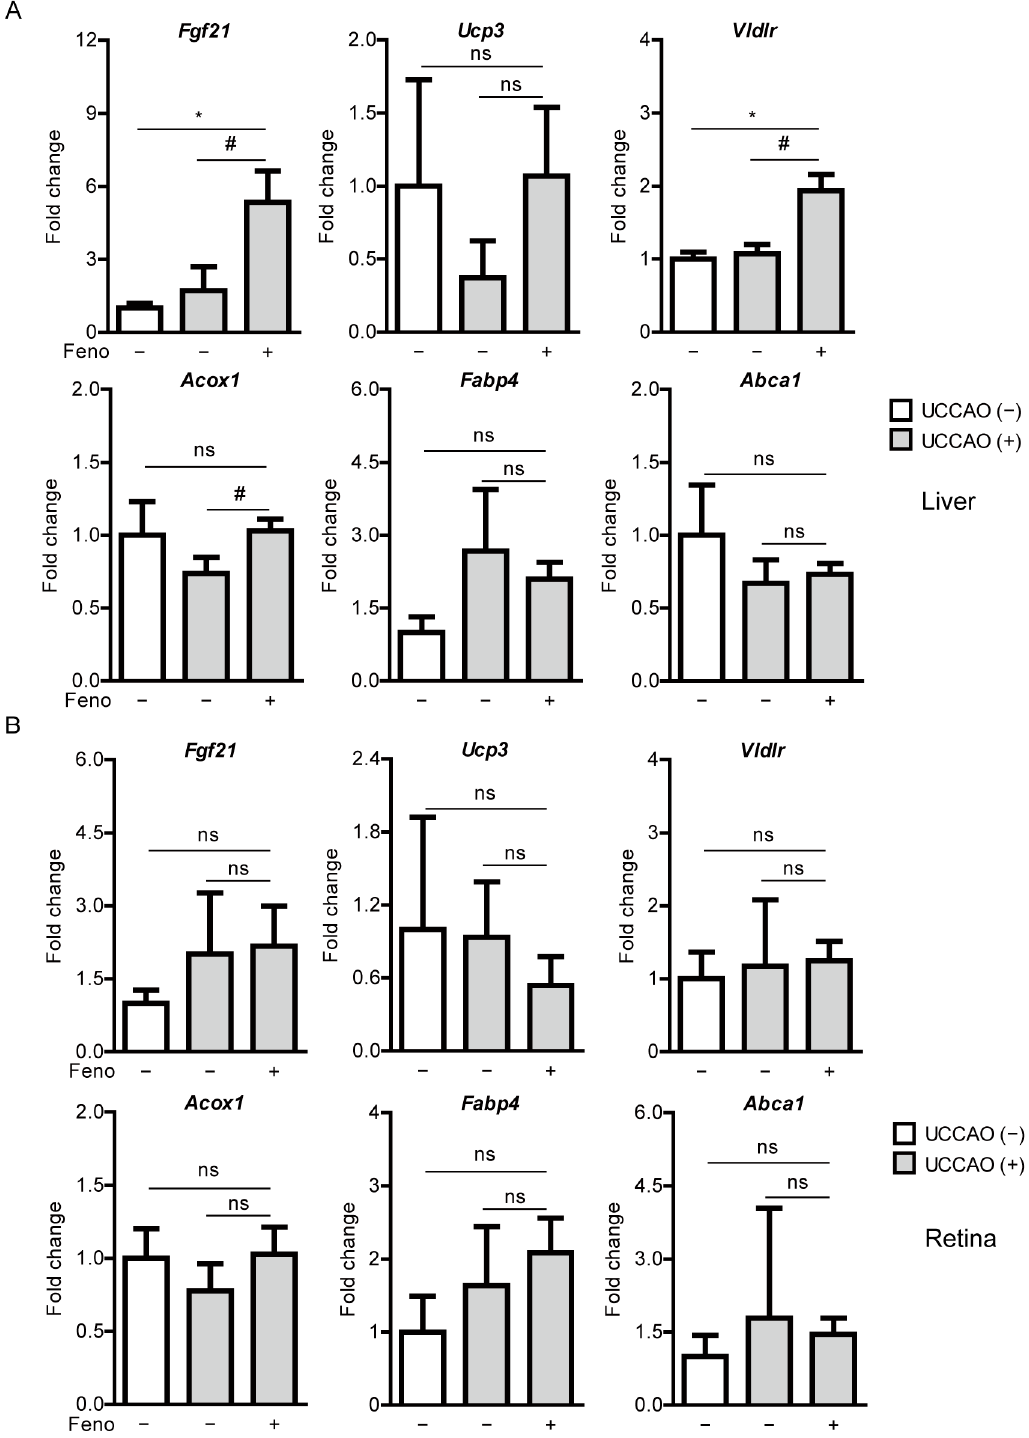
Figure 4. Increases in PPAR α downstream gene expressions in the liver by oral administration of fenofibrate in the UCCAO-operated mice. ( A ) Quantitative analyses ( n = 3 for sham group; 4–5 per UCCAO group) show that oral administration of fenofibrate significantly increased Fgf21 , Vldlr, and Acox1 expressions in the liver 7 days after UCCAO. ( B ) Quantitative analyses ( n = 3 for sham group; 4–5 per UCCAO group) show that oral administration of fenofibrate did not change expressions of PPAR α downstream gene in the retina. * p < 0.05 (one-way ANOVA), # p < 0.05 (Student’s t -test). The data were analyzed using Student’s t -test (two-tailed) or one-way ANOVA followed by a Bonferroni post hoc test and presented as mean ± standard deviation. Feno; fenofibrate. UCCAO; unilateral common carotid artery occlusion.